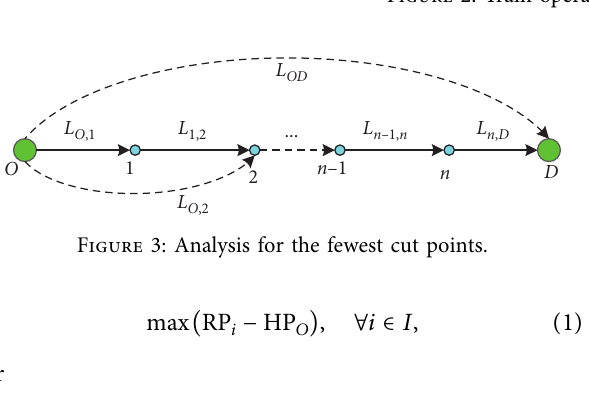
Figure 2: Train operation process of the HSM.